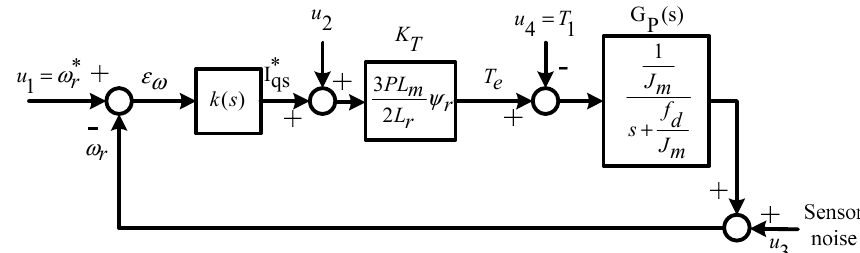
Figure 2. Block diagram of the speed-control system of an IFO-controlled induction motor drive.